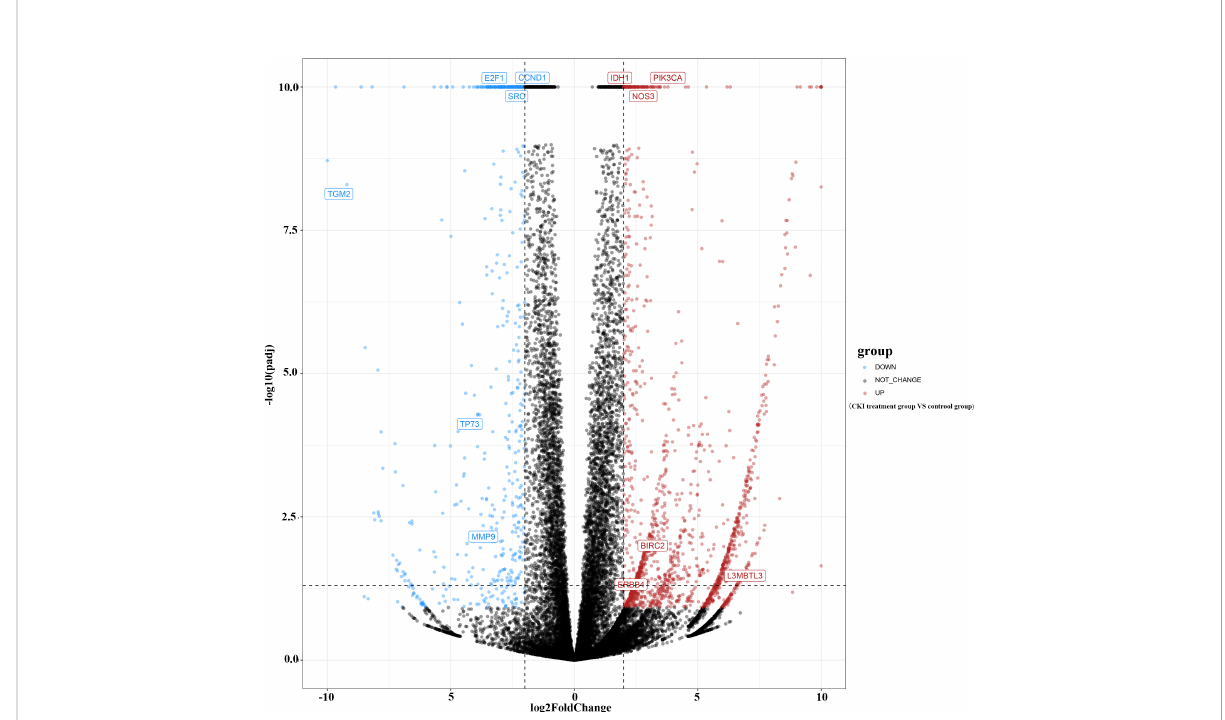
FIGURE 2 Gene difference analysis of chip GSE78512. Notes: The – log10(padj) was set equal to 10 when it was greater than